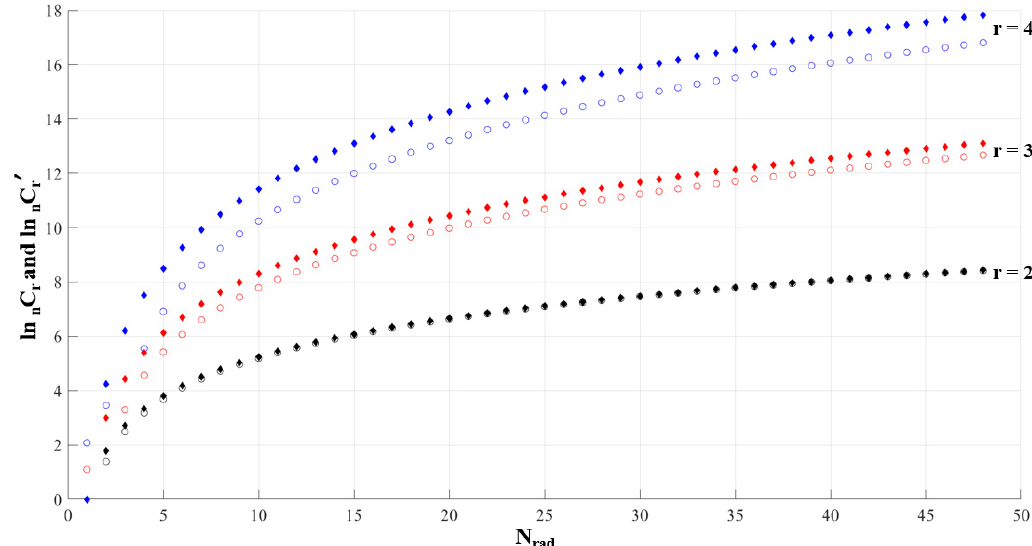
Figure 6. The logarithmic difference between Equation (1) and Equation (8). The circular points are n C r and the diamonds n C r ’. As r increases so does the difference between n C r and n C r ‘.